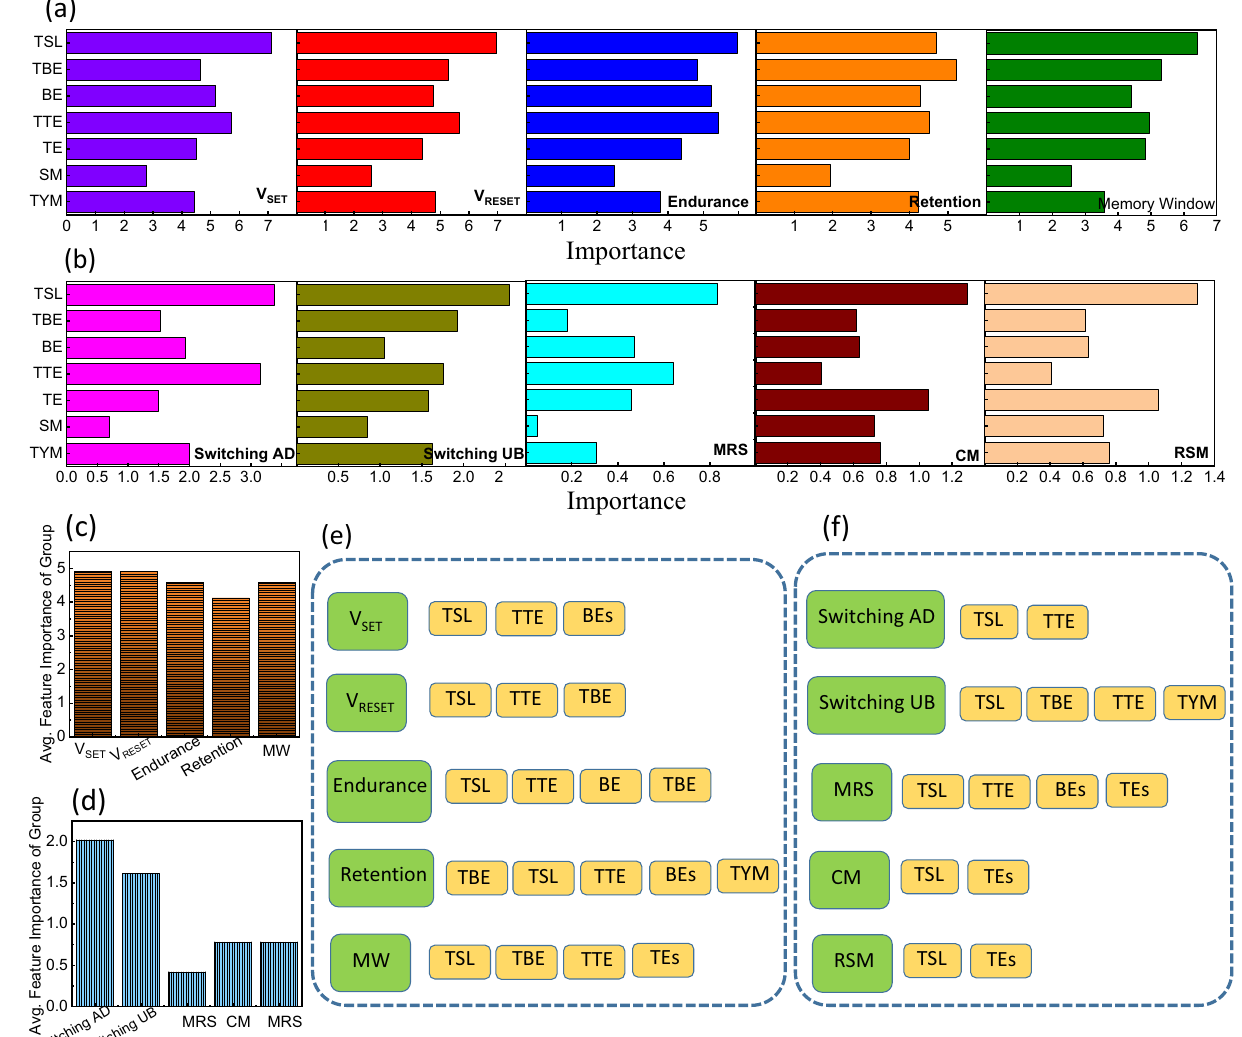
Figure 7. Feature importance score of the continuous and categorical output features. ( a ) Feature importance of continuous features (V SET , V RESET , EC, RT, and MW) and ( b ) categorical features (TSUB, TSAD, MRS, CM, and RSM). Average feature importance of ( c ) continuous features and ( d ) categorical features and ( e,f ) corresponding significant device fabrication